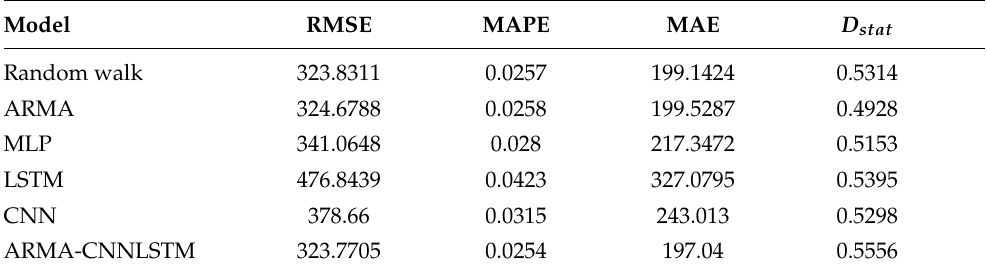
Table 4. Comparison of the predictive abilities of different models for Bitcoin’s closing prices.